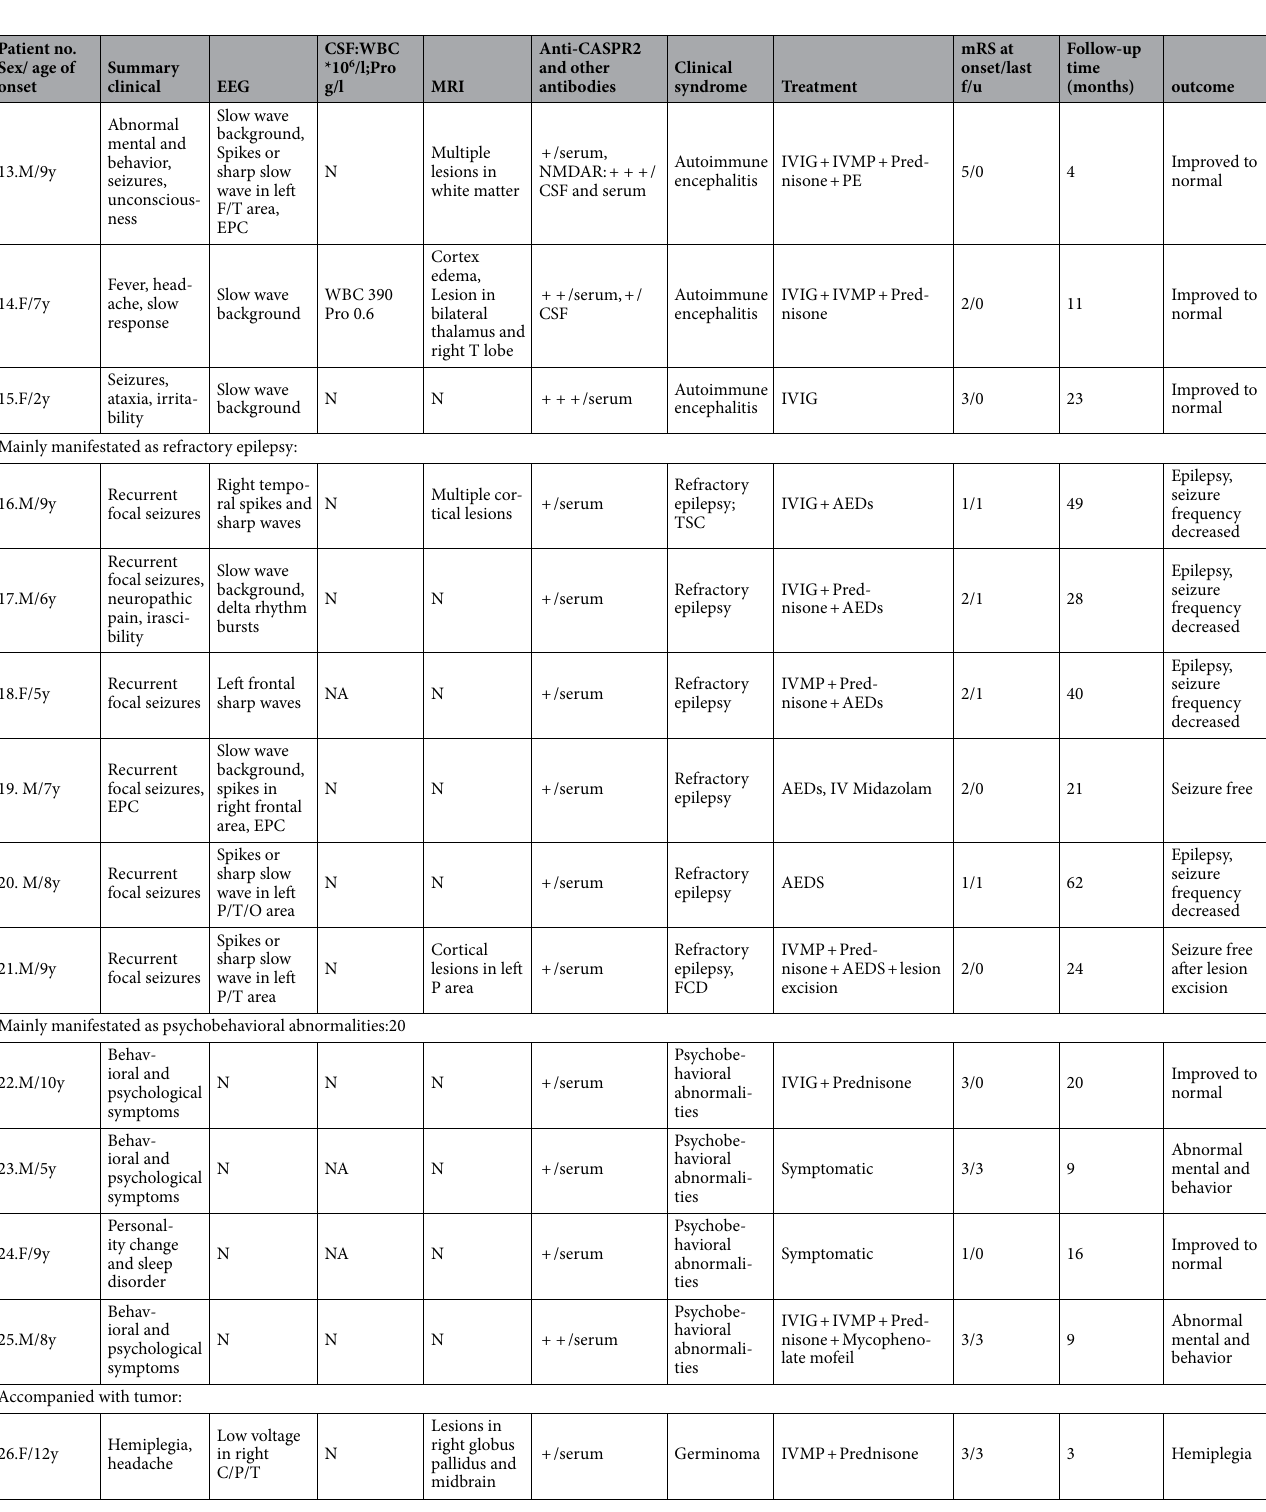
Table 1. Clinical features, auxiliary examinations, diagnosis and treatment strategies, prognosis in pediatric patients seropositive for CASPR2-IgG. M : male, F : Female, N : normal, F : Frontal, P: Parietal, O : Occipital, T : Temporal, AED : antiepileptic drug, CSF : Cerebrospinal fluid, WBC : white blood cell in CSF, Pro : protein in CSF, EEG : electroencephalography, MRI : magnetic resonance imaging, mRS : modified Rankin Scale, IVIG : intravenous immunoglobulin, IVMP : intravenous methylprednisolone, TSC : tuberous sclerosis, NA : not available, PE : plasma exchange, EPC : epilepsia partialis continua, FCD : focal cortical